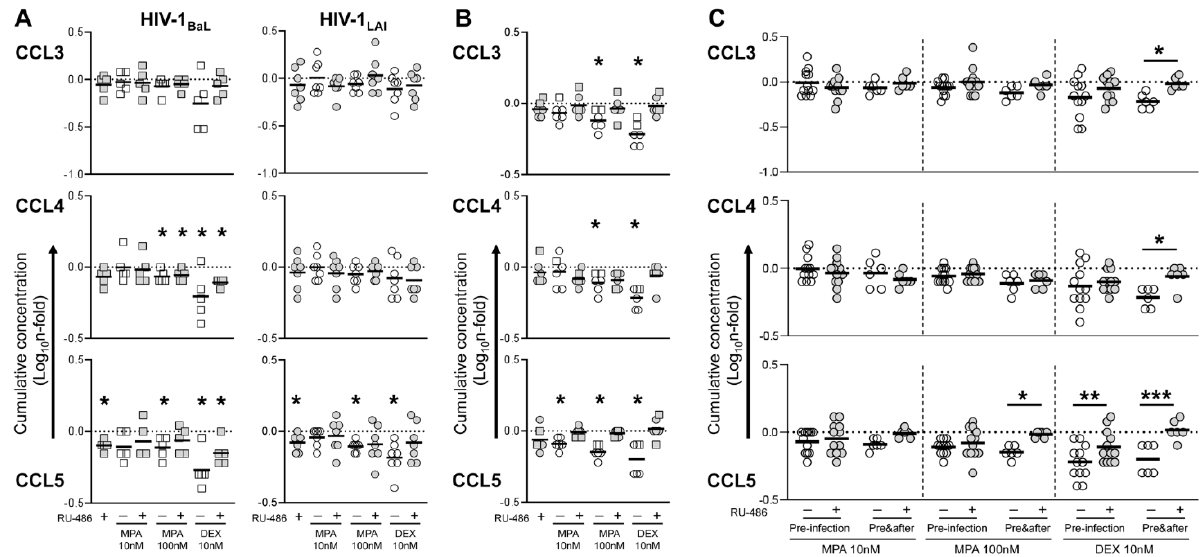
Figure 4. Cytokine production in HIV-infected tonsillar tissue explants treated with steroid hormones. Cytokine levels were measured in culture supernatant of tonsillar tissue explants treated with medroxyprogesterone acetate (MPA) and dexamethasone (DEX) at the indicated concentrations, in the presence or the absence of mifepristone (RU- 486) at 1 μM, prior to infection (pre-infection, ( A )), or before and after (pre & after ( B )) infection with HIV-1, as indicated in Figures 1 and 2. ( A ) N-fold change in cumulative cytokine production (Day 3 to Day 12 post-infection) of explants infected with HIV-1 BaL (squares, n = 5) and HIV-1 LAI (dots, n = 7) compared to donor-matched untreated explants (VEH). Lines indicate mean values. Asterisks denote a statistically significant difference with VEH (one sample t test,* p < 0.05, ** p < 0.01, *** p < 0.001). ( B ) N-fold change in cumulative cytokine production (Day 3 to Day 12 post-infection) of explants infected with HIV-1 BaL (squares, n = 1 – 2) and HIV-1 LAI (dots, n = 4) compared to donor-matched untreated explants (VEH). Lines indicate mean values. Asterisks denote a statistically significant difference with VEH (one sample t test,* p < 0.05, ** p < 0.01, *** p < 0.001). ( C ) N-fold change in cumulative cytokine production of explants treated with the indicated MPA con- centration prior to infection (pre-infection, n = 12) or before and after infection (pre & after, n = 5 – 6) compared to donor- matched VEH. Lines indicate mean values. Asterisks denote a statistically significant difference between each treatment group and the respective RU-486-treated control (two- way ANOVA with Sidak’s multiple comparisons test, * p < 0.05, ** p < 0.01, *** p < 0.001).